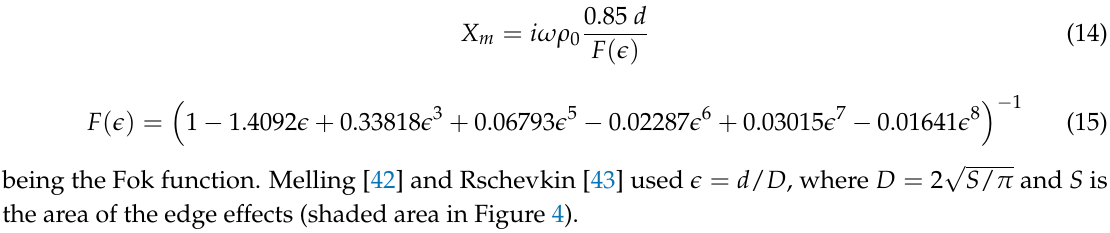
Figure 4. Meaning of b and d in the definition of 𝜖 for the Fok function.